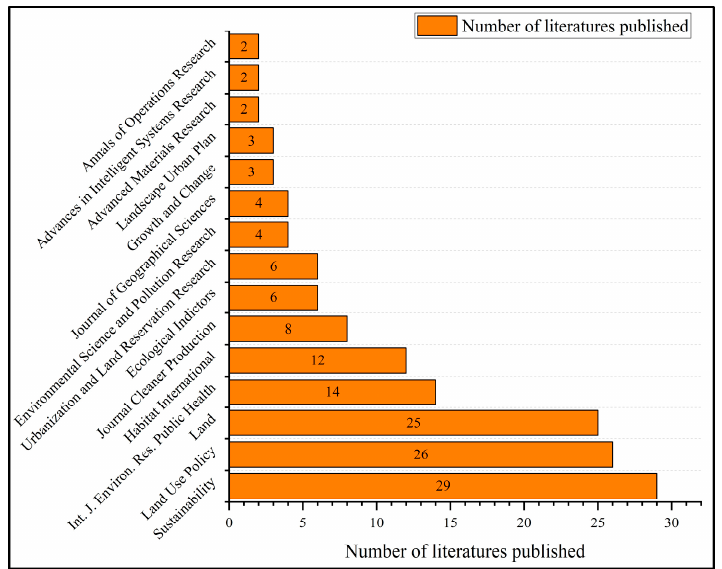
Figure 3. Main published journals and the number of publications in the literature (Abbreviation for a published journal: International Journal of Environmental Research and Public Health-Int. J. Environ. Res. Public Health).